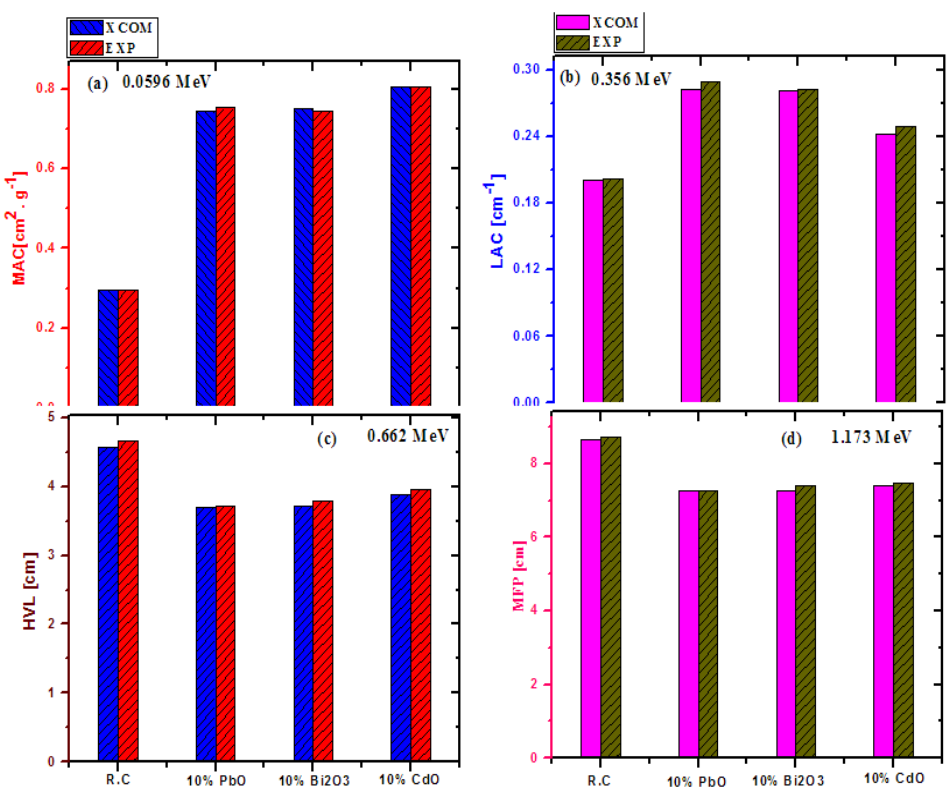
Figure 3. The difference between the experimental and XCOM results of ( a ) MAC at 0.0596 MeV, ( b ) LAC at 0.356 MeV, ( c ) HVL at 0.662 MeV and ( d ) MFP at 1.173 MeV for red clay, as well as different 10% wt doped oxide-clays.